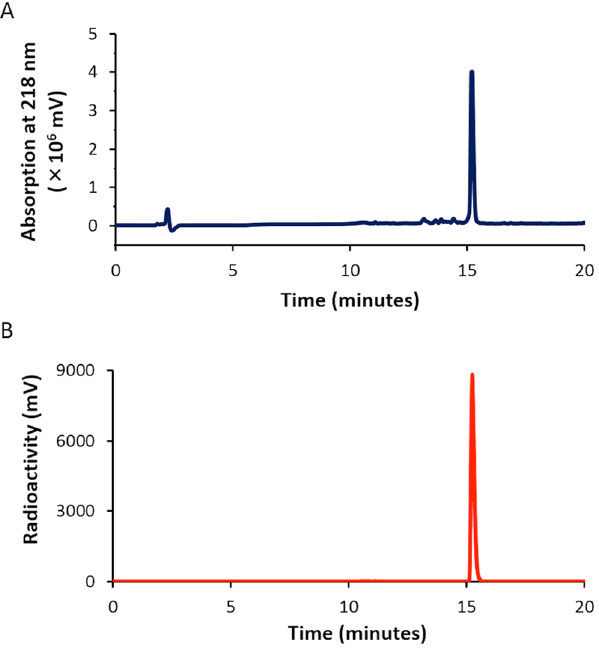
Figure 11. HPLC profiles of 4 -RGD (absorbance at 218 nm, A ) and [ 125 I] 4 -RGD (radioactivity, B ).